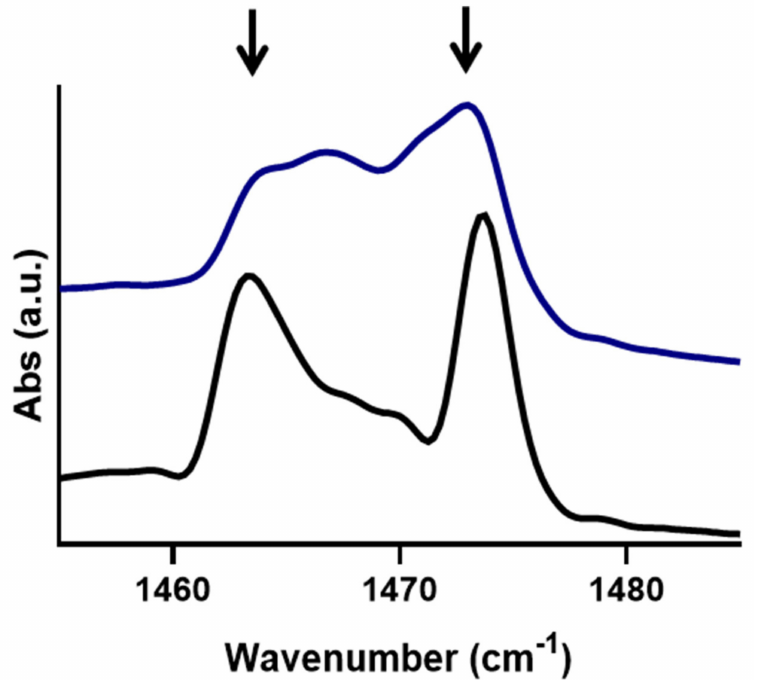
Figure 2. The δ CH 2 splitting effects when containing either FFA C24 (black) or FFA C16 (blue) at 10 ◦ C. Black arrows indicate the position of the orthorhombic